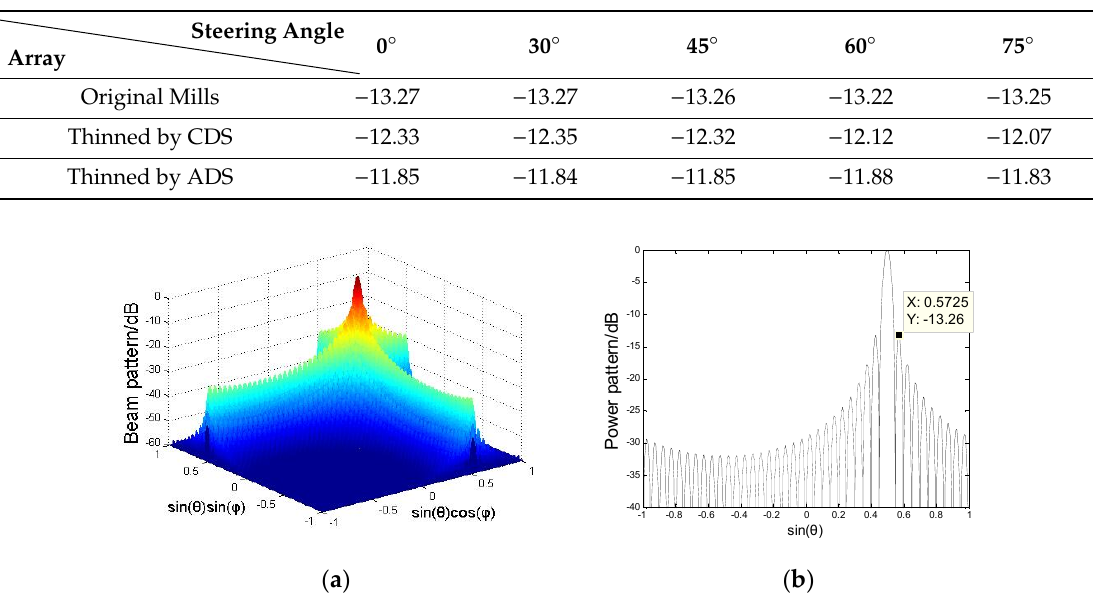
Figure 8. Beam power pattern of the original Mills Cross array. ( a ) 3D pattern; ( b ) 2D section pattern.